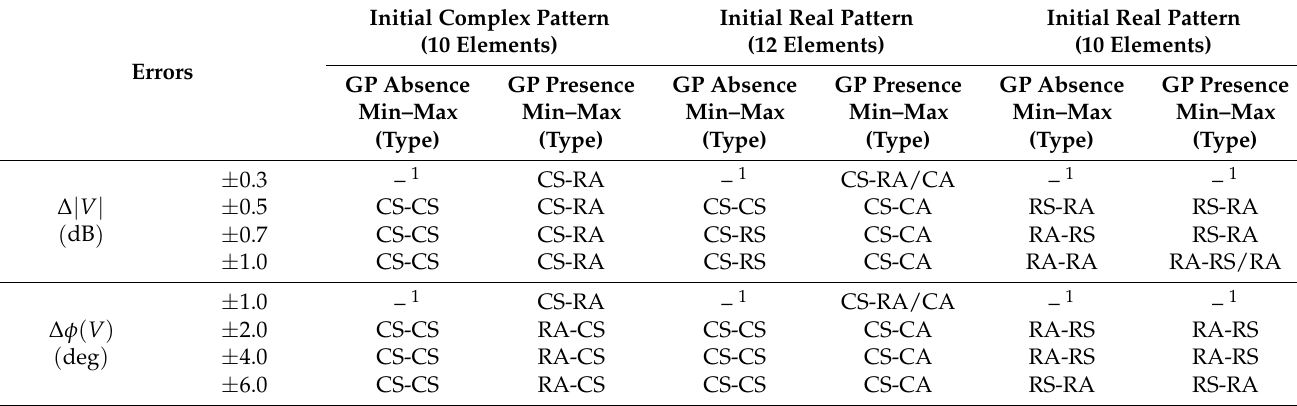
Table 9. Nature of the solutions with maximum and minimum rate of success in tolerance analysis of Figure 13: Linear array of half-wavelength dipoles in absence and in presence of ground